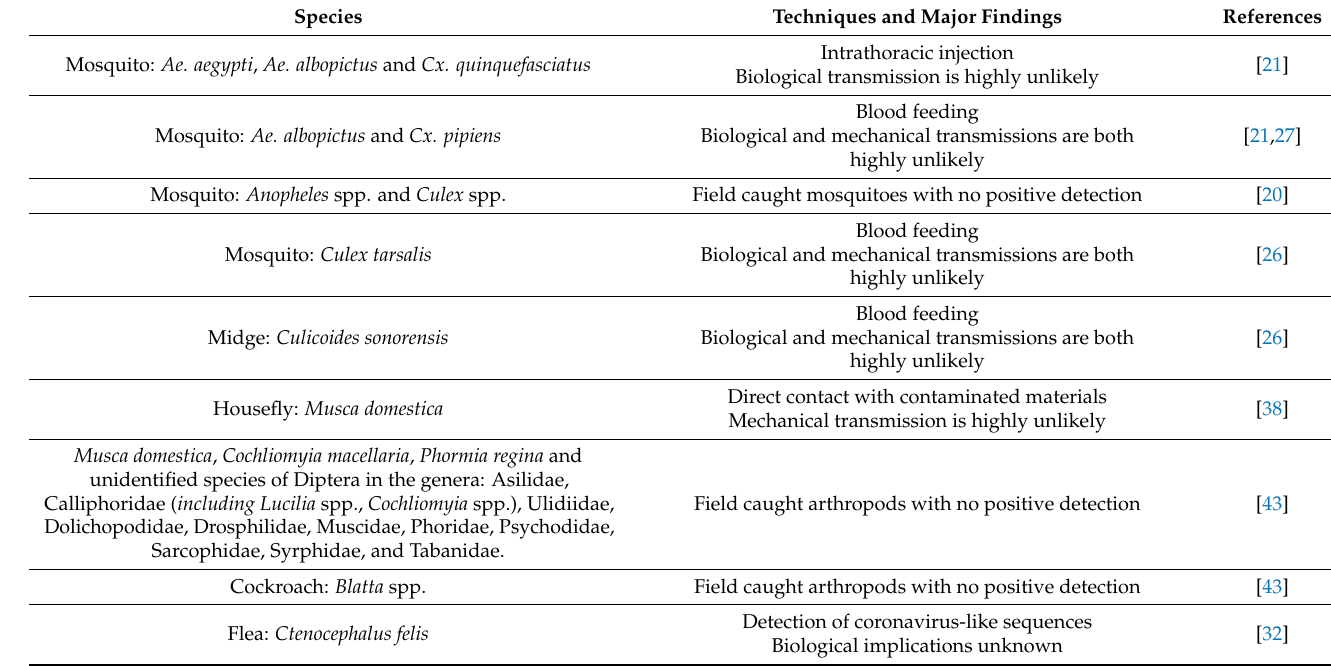
Table 1. Summary of published studies examining the role of arthropod species in the transmission of SARS-CoV-2. Species Techniques and Major